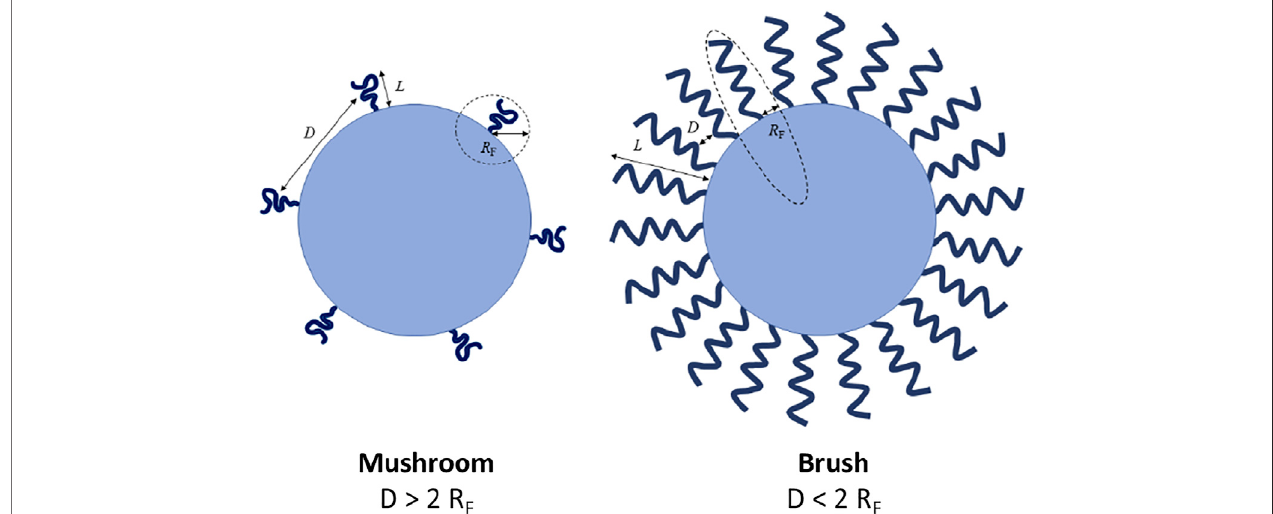
FIGURE3| BrushandmushroomconformationofPEGonananoparticlesurface.D:distancebetweentwograftingsites;L:thicknessofthegraftedPEG;R F :Flory radius. Figure from (Fam et al., 2020).